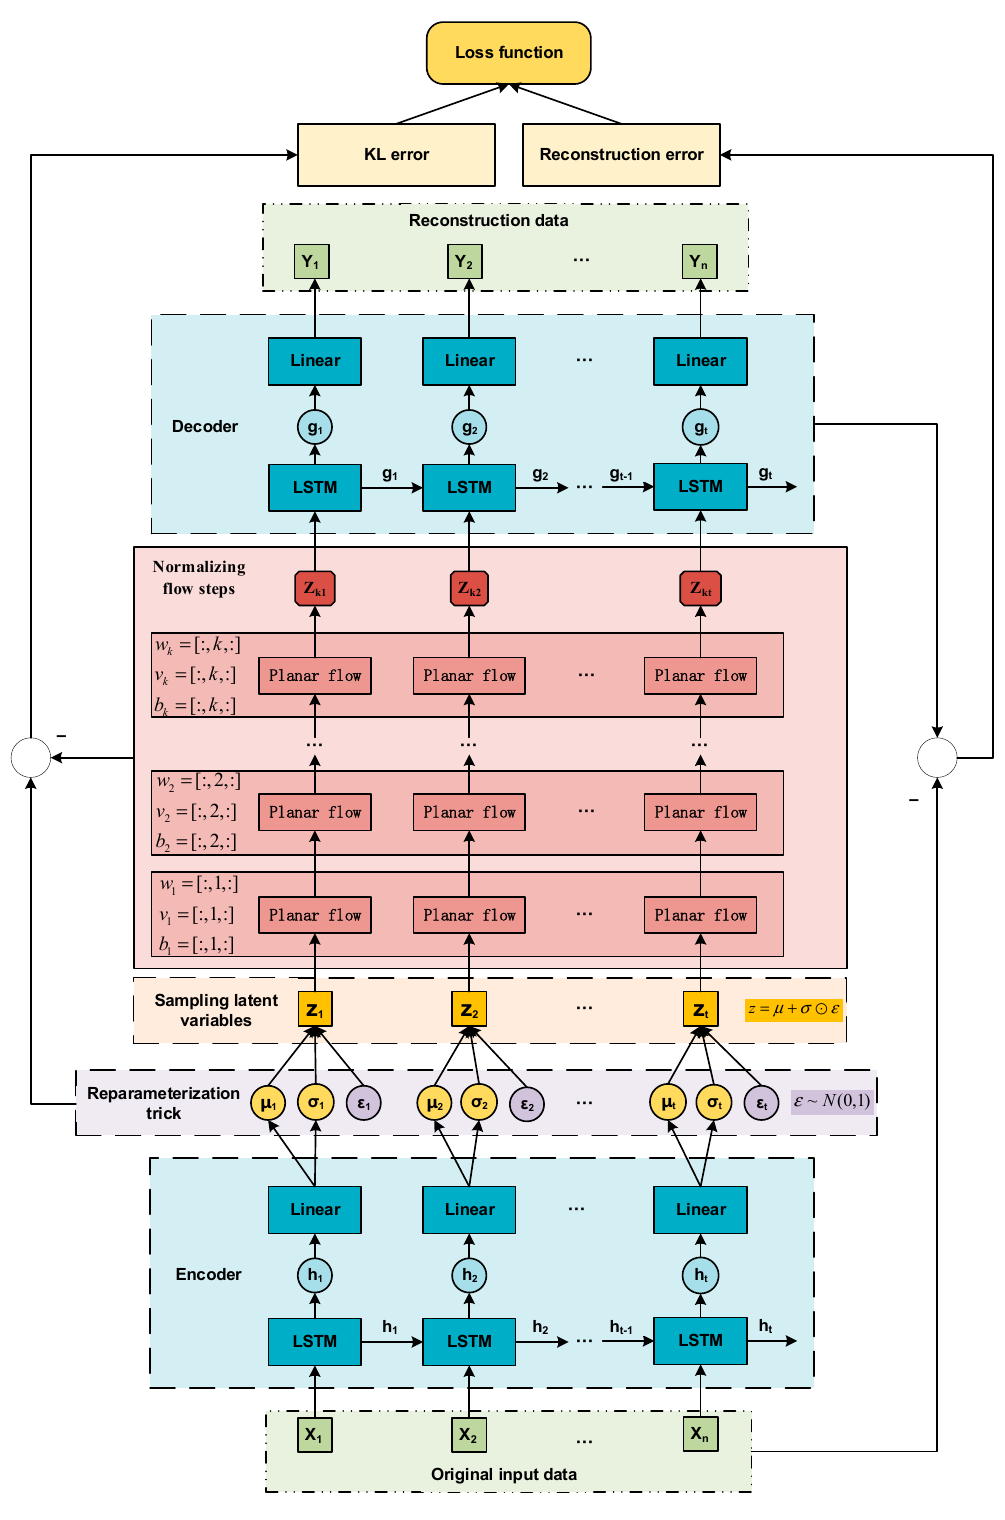
Figure 4. PFVAE prediction model structure.